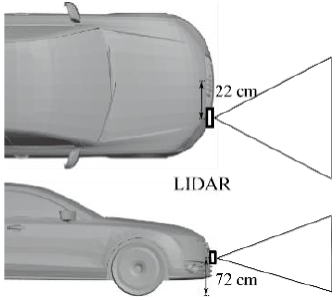
Figure 3. Placement of the LIDAR sensor in the ego vehicle (based on [10]). Table 1. Highway measurements (taken from